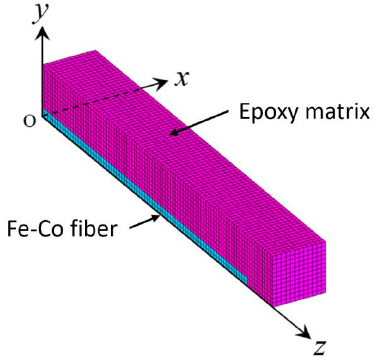
Figure 4. Modeling and meshing of the discontinuous Fe-Co fiber/epoxy composite. In this study, the finite element calculation was performed under stress-free conditions on the z = 𝐿 lm /2 plane to determine the piezomagnetic constants from the strain generated by the magnetic field. We applied the magnetic induction B z along the z -direction. The magnetic potential is zero on the z = 0 plane, and the magnetic field H z ( x , y , 𝐿 lf /2) is given by the equation, H z = 2 0 / 𝐿 lf , where 0 is the magnetic potential at z = 𝐿 lf /2 plane. The magnetic induction B z ( x , y , 𝐿 lf /2) is given by the equation, B z = 0 H z , where 0 is the magnetic permeability in the epoxy matrix (free space). The piezomagnetic constants 𝑑 33uc and 𝑑 31uc of unidirectional aligned Fe-Co short fiber composites are given by